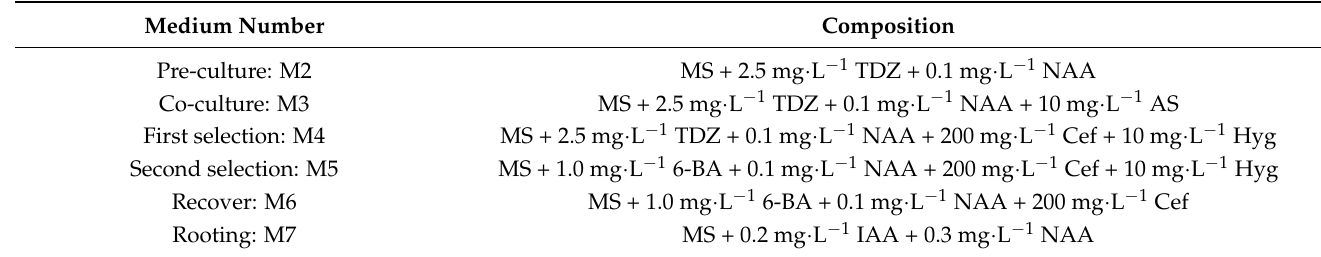
Table 2. Mediums used for G. paniculata genetic